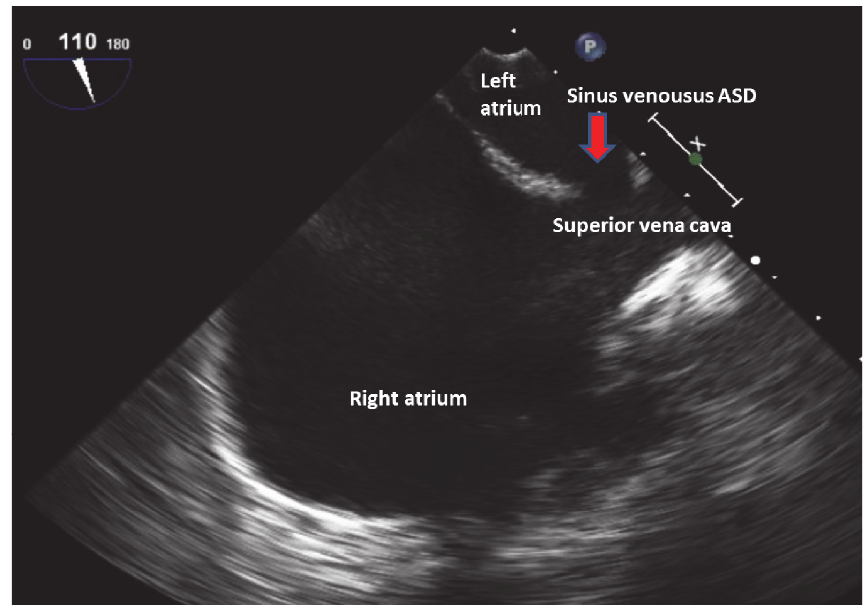
Figure 4: A bicaval view via a transesophageal echocardiogram shows communication (red arrow) between the left atrium and the superior vena cava